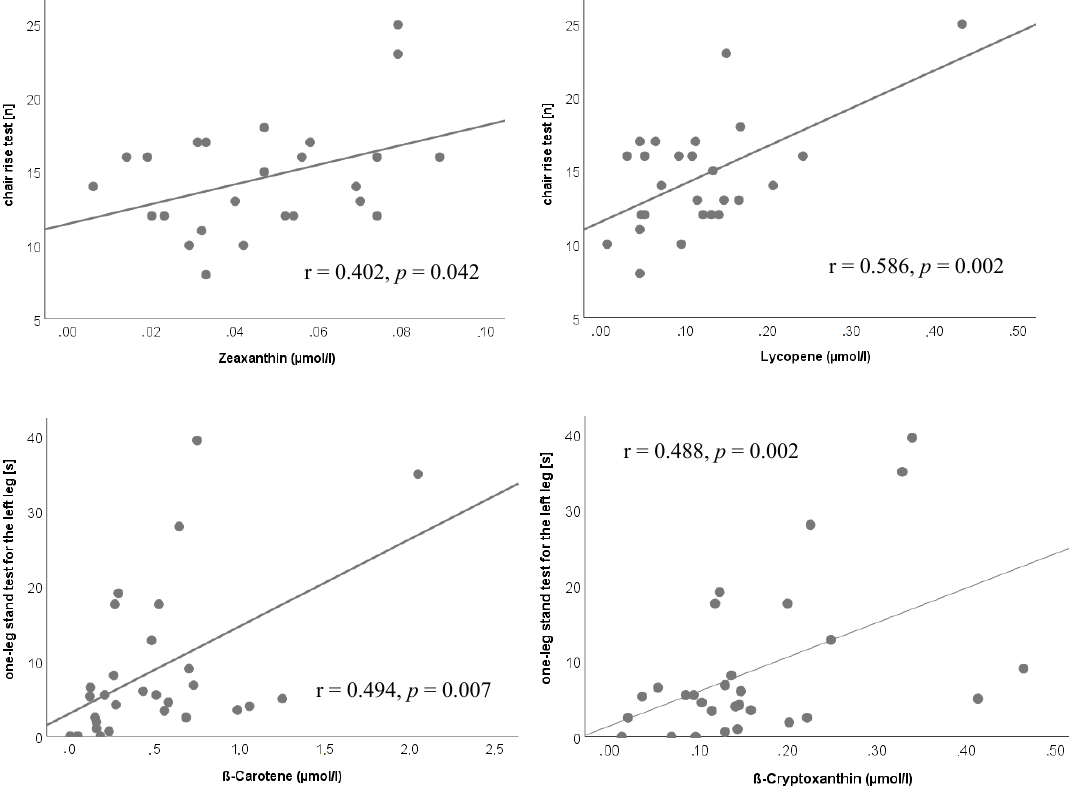
Figure 2. Correlations after 6 months of intervention in the resistance trained (RT) group.